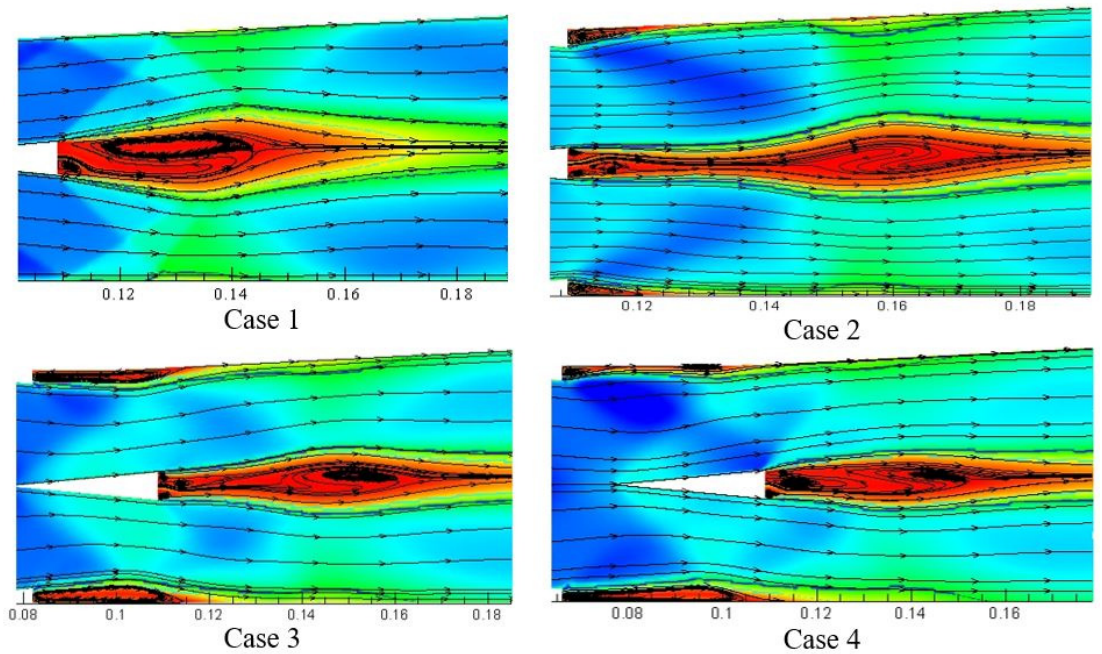
Figure 8. Recirculation region for different 2D scramjet models.